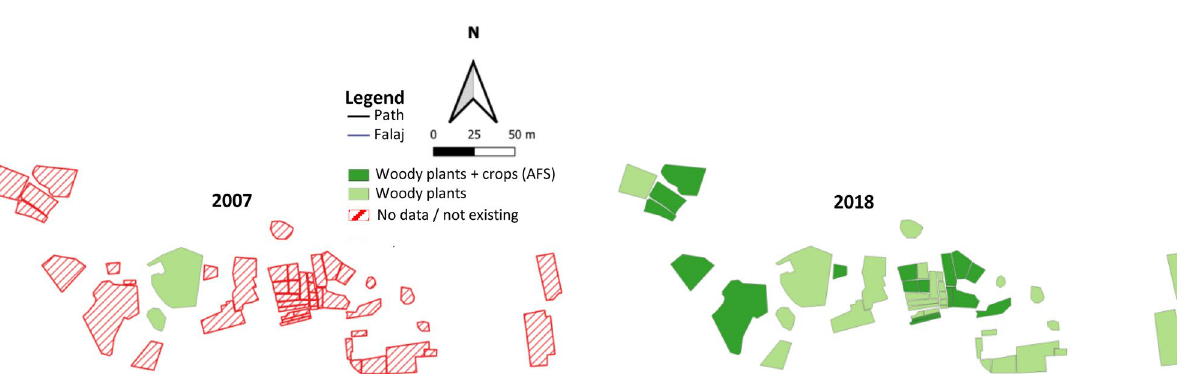
Figure 10. Landuse map of the oasis Qanfarah (1700 m a.s.l.) in Wadi Muaydin (Al Jabal Al Akhdar, Oman) in 2007 and